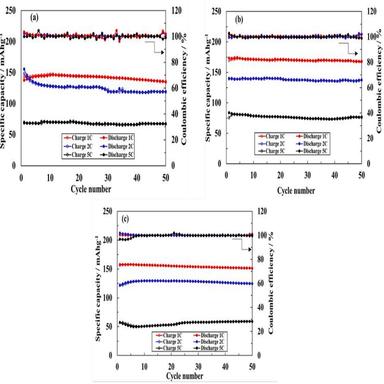
Cycling properties and coulombic efficiencies of LZTNO (a) x ¼ 0, (b) x ¼ 0.05 and (c) x ¼ 0.1 respectively.